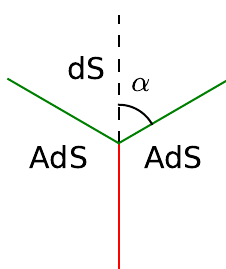
Figure 3 . The brane bifurcation into the dS-AdS domain